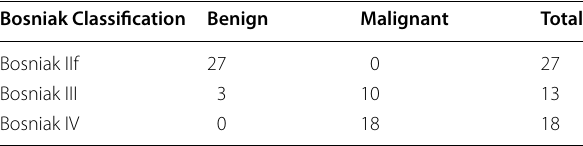
Table 4 Bosniak classification of cystic lesions in the kidney group